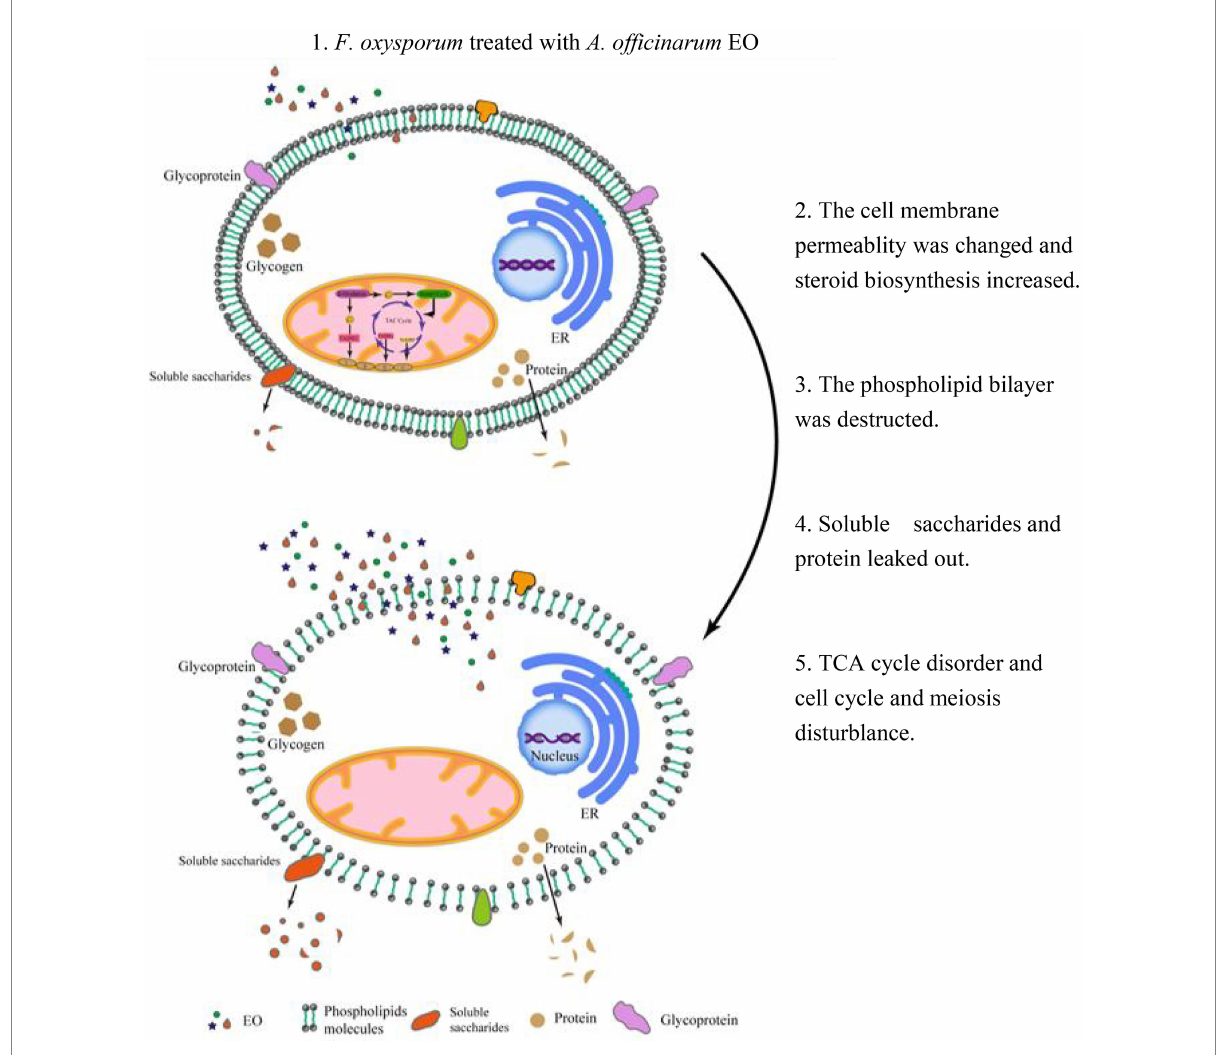
FIGURE 9 The mechanism overview of A. officinarum EO on F. oxysporum